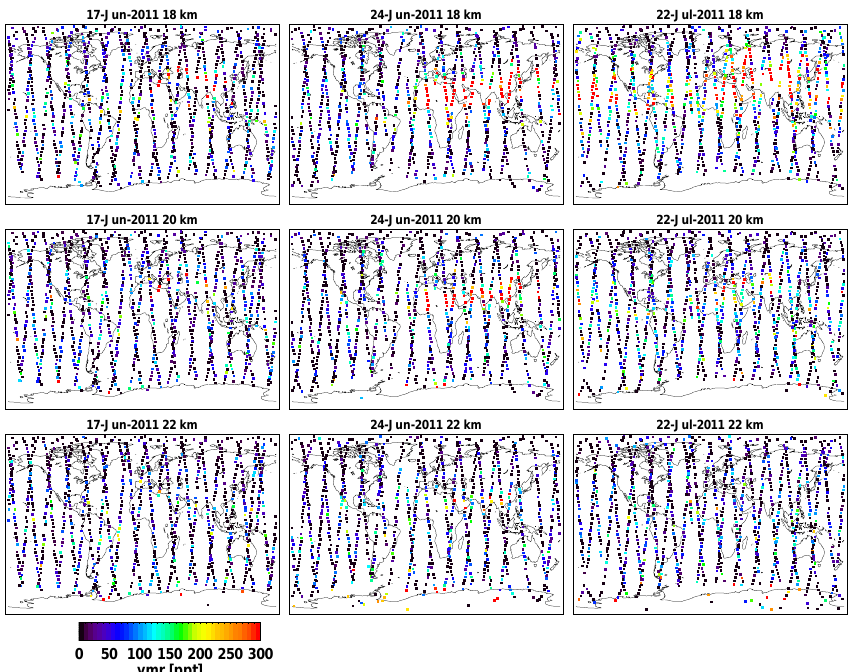
Figure 9. Example from the MIPAS data set of SO 2 for 3 days and at three altitude levels after the eruption of Nabro on 12 June 2011. Note that the colour scale does not cover the entire range of the data such that vmr values > 300pptv are set to the colour at 300pptv (red) and negative values to 0